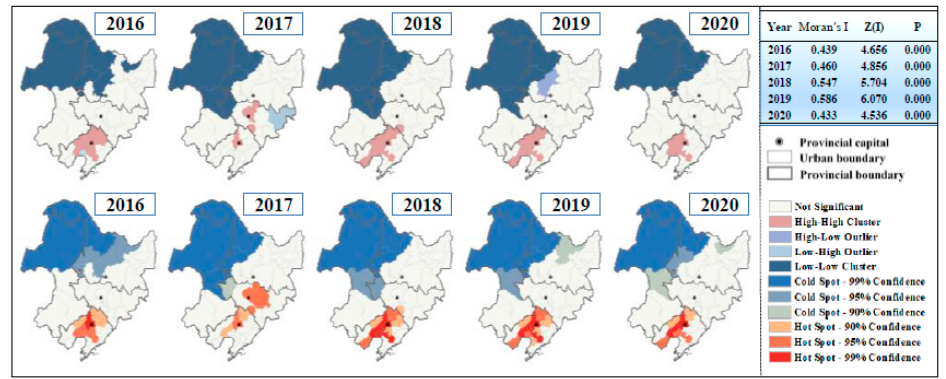
Figure 6. Results of spatial autocorrelation analysis and hot spot analysis of PM 2.5 concentration in Northeast China from 2016 to 2020. The detailed calculations are shown in the table on the right.